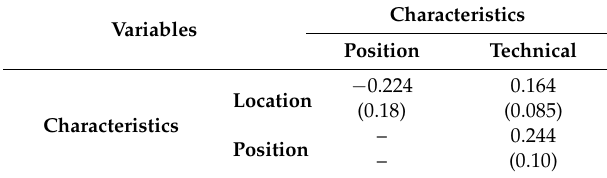
Table 5. Pearson correlations test of the resident samples (112 cases; Sig. 2-code in brackets).